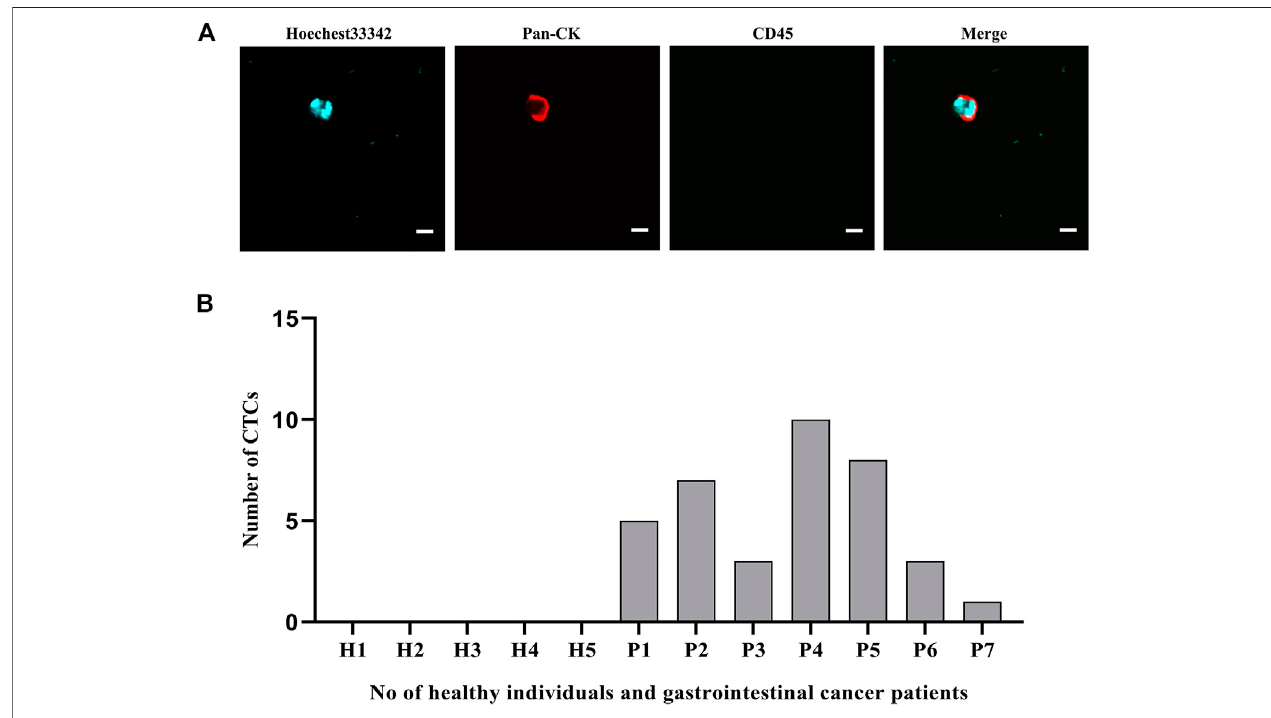
FIGURE 8 | (A) Representative fl uorescent images of captured CTCs. (B) Quanti fi cation of the CTCs captured from the peripheral blood (5 ml) of patients with gastrointestinal tumors. Scale bar: 20 μ